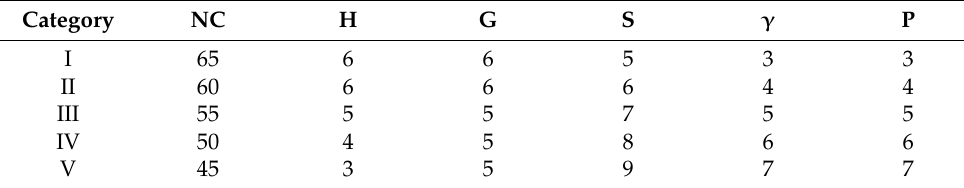
Table 3. ASTM facility categories based on image quality parameters [20].